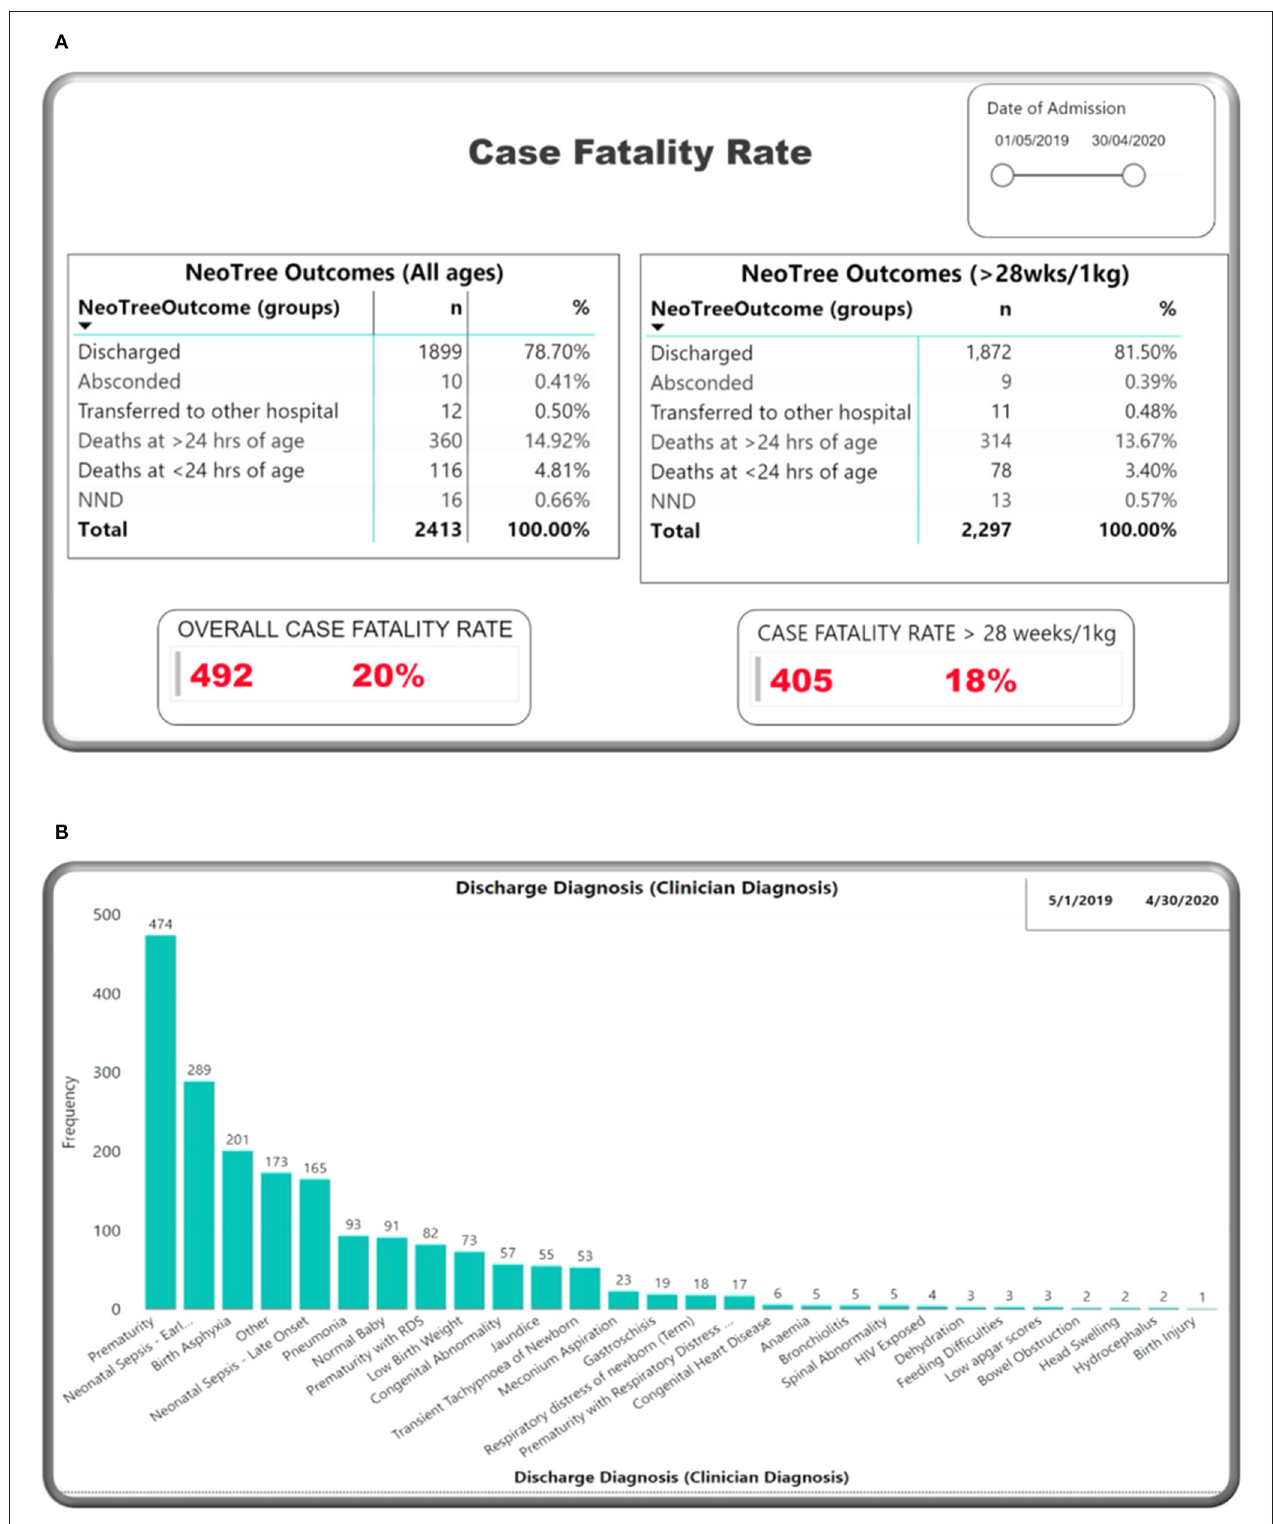
FIGURE 5 | M&M dashboard visuals: (A) Outcomes, (B) discharge diagnosis.